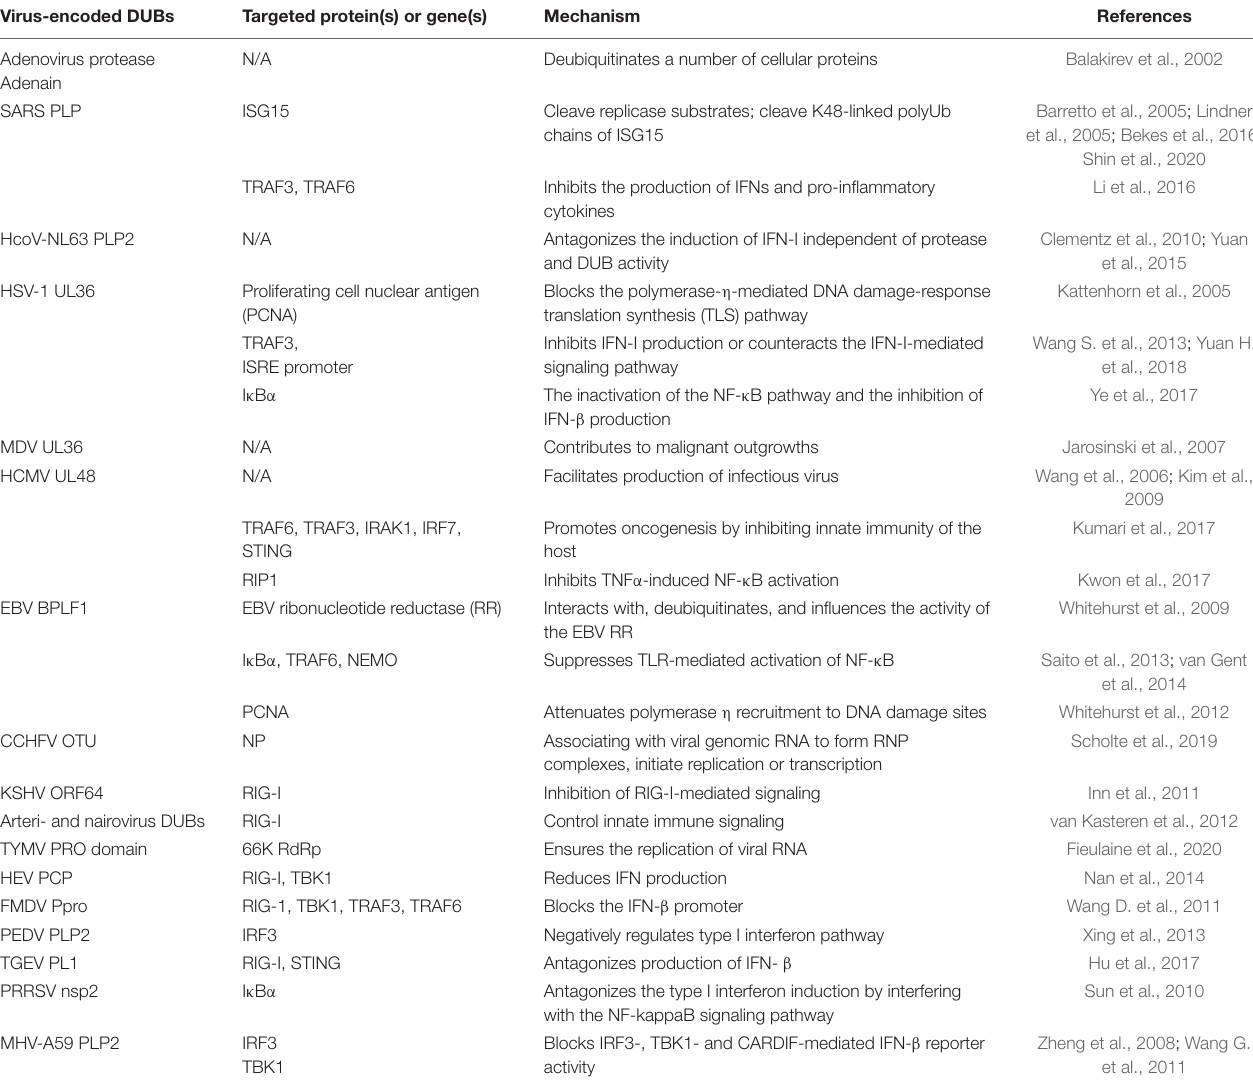
TABLE 2 | Virus-encoded DUBs and the targeted proteins or